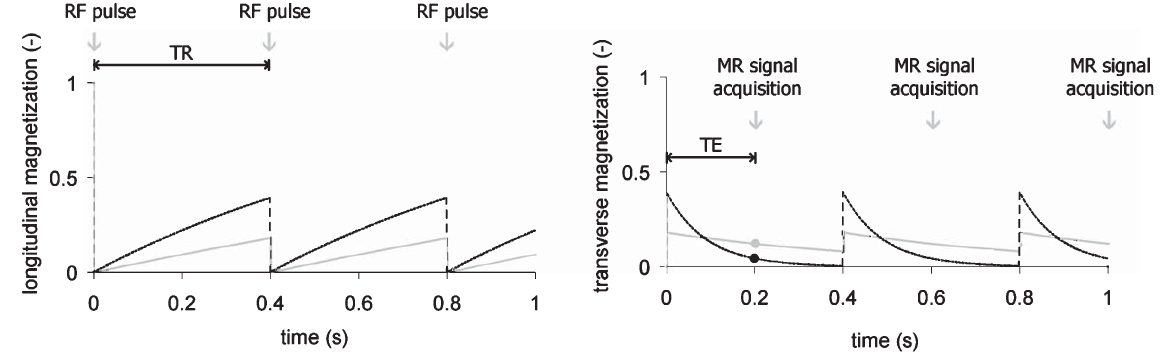
Fig. 3. Differences in the spin-lattice (T 1 ) and spin-spin (T 2 ) relaxation times of tissue compartments can be emphasized by intelligent manip- ulation of acquisition parameters, such as echo time (TE) and repetition time (TR). In the left panel, the longitudinal magnetization of white matter (black) with T 1 =0.8ms recovers faster than cerebrospinal fluid with T 1 =2s (gray). The differences are seen using a relatively short repetition time (0.4s). In the right panel, the signal from liver (black), which has a short T 2 =40ms, diminishes faster than the signal from fat, with a longer T 2 of 60ms (gray). These differences are captured at an echo time of 20ms. This figure has been adapted from [25]. It is reprinted with permission from the ILAR Journal, Institute for Laboratory Animal Research, National Research Council, Washington, DC